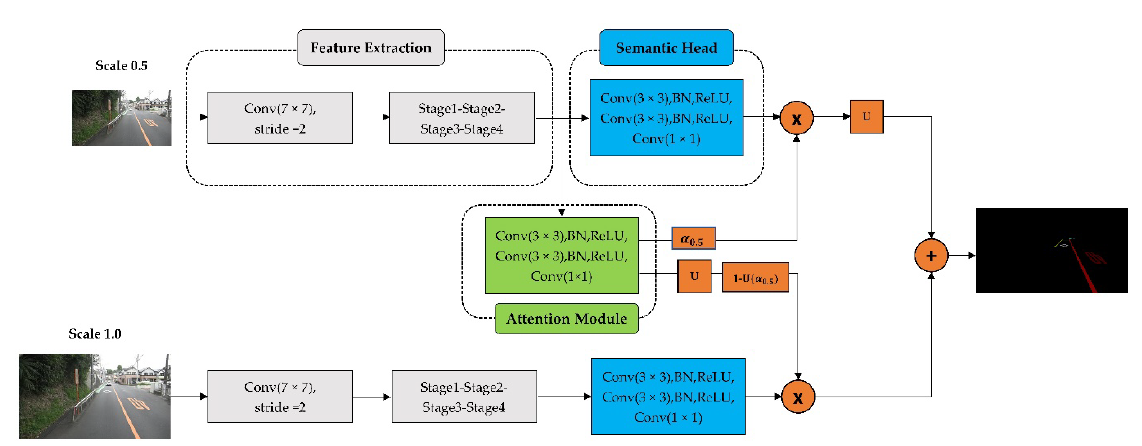
Figure 4. The procedure of the training process of the proposed method.